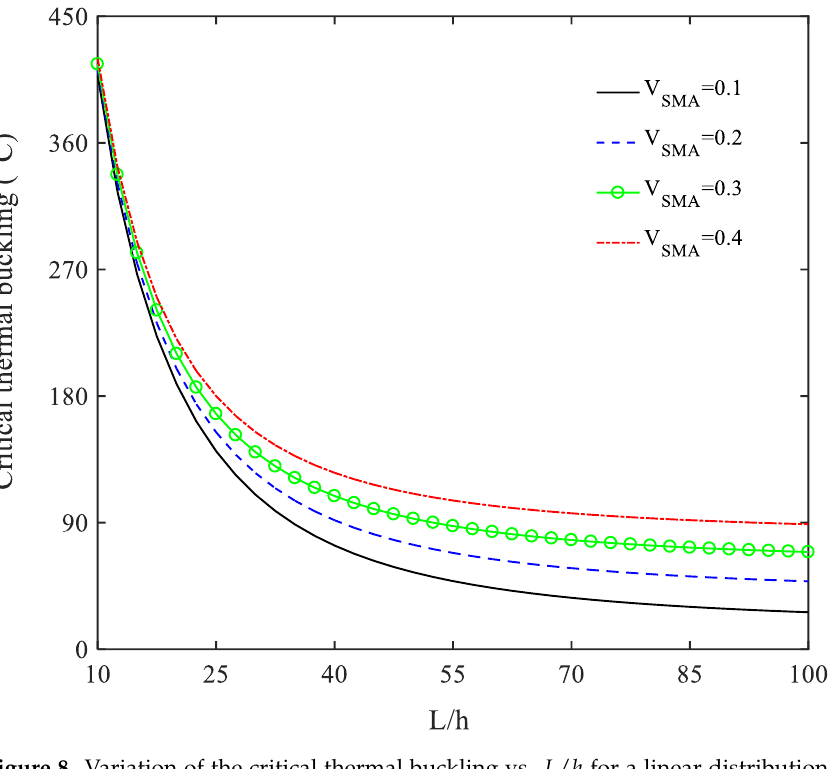
Figure 8. Variation of the critical thermal buckling vs. L / h for a linear distribution and different values of V SMA ( n = 1, h c / h = 0.8 and ε 0 = 2%).